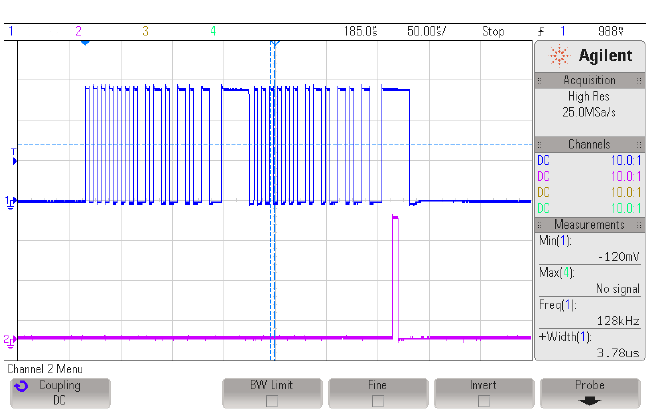
Figure 15. Oscilloscope capture of HCMP output and PIC interrupt during a WuPt decoding.